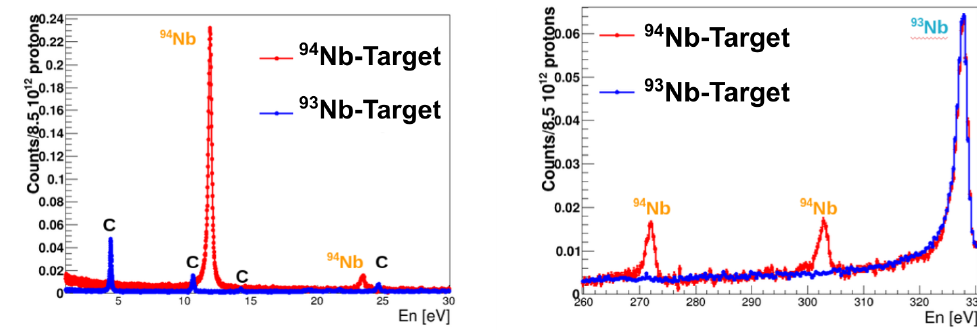
Figure 3. Comparison between experimental yield after background subtraction for 94 Nb and 93 Nb- spiral configurations for two selected neutron energy ranges. The 94 Nb, 93 Nb and contaminant reso- nances are tagged by orange, light-blue and black colors,